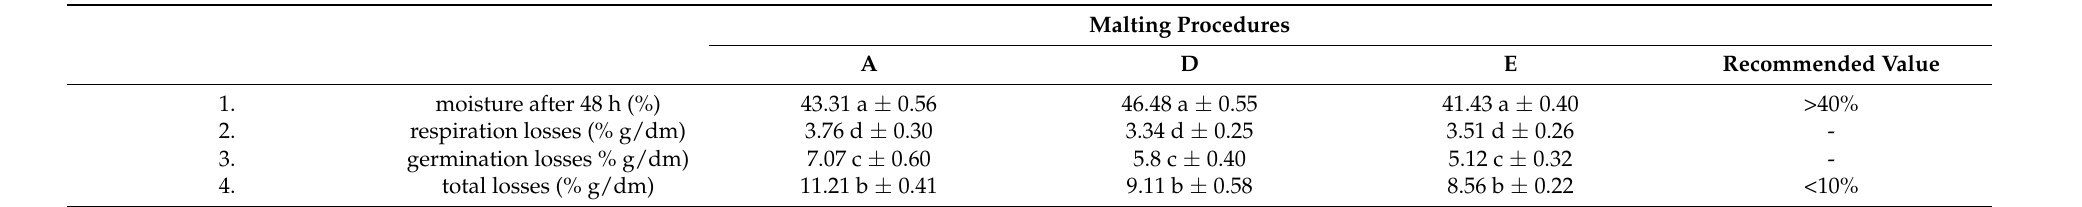
Table 4. Mean values of the testing varieties for the quality parameters of the micromalting process by season and malting procedures. Malting Procedures